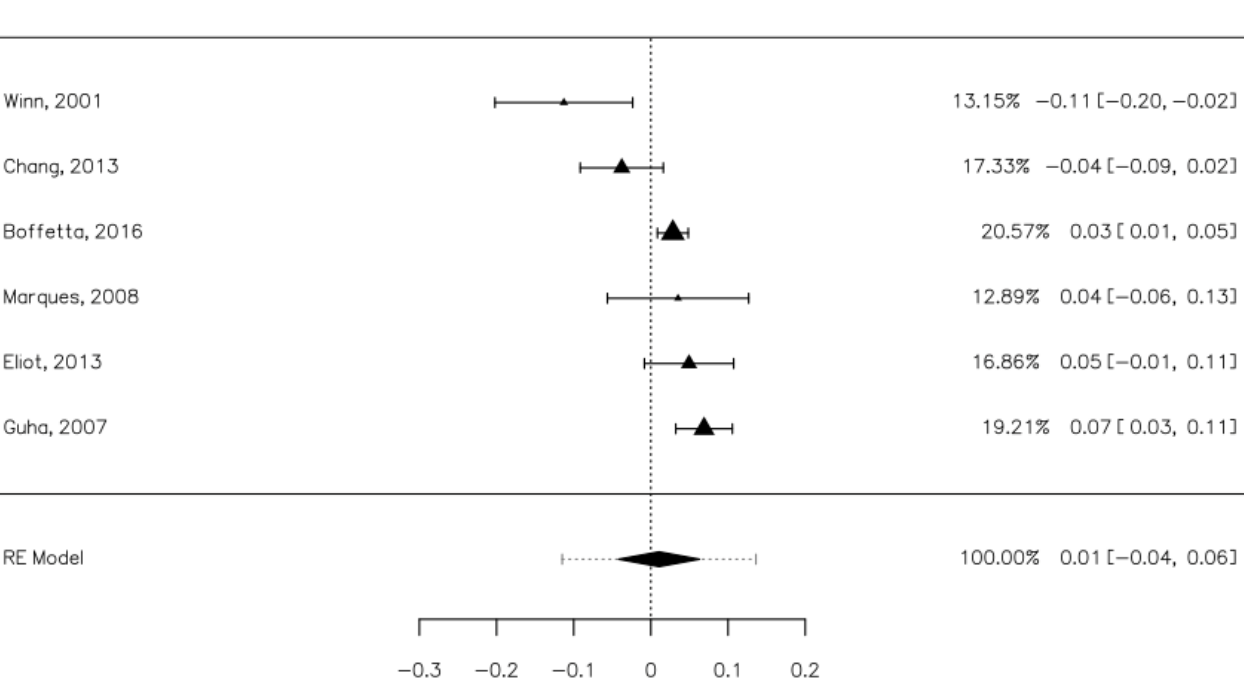
Figure 5. Forrest plot. The risk of pharyngeal cancer associated with mouthwash use.